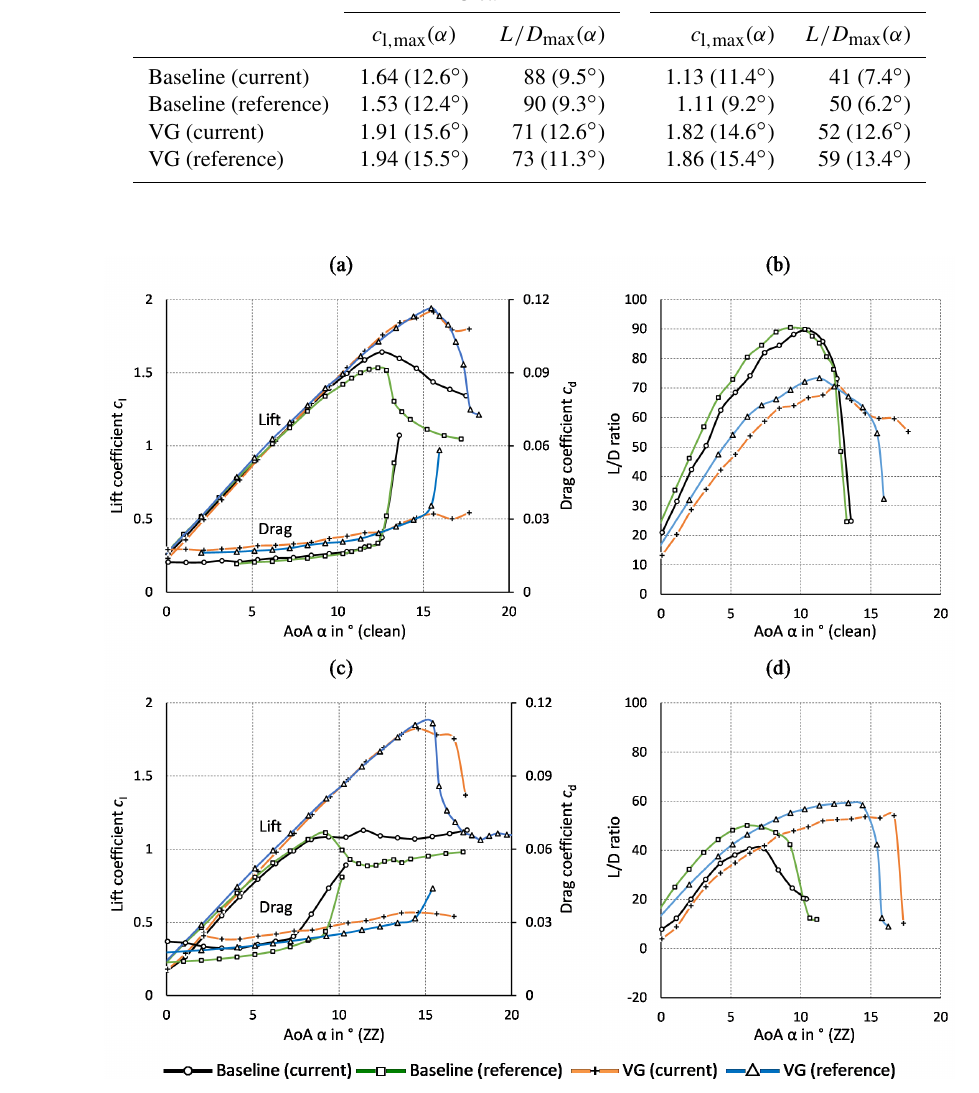
Figure C1. DU97W300. Clean and tripped cases. Baseline and VG configurations at Re = 1 . 5 × 10 6 compared to reference data from Baldacchino et al. (2018) at Re = 2 × 10 6 . (a) Lift and drag coefficients. (b) Lift to drag ratio.